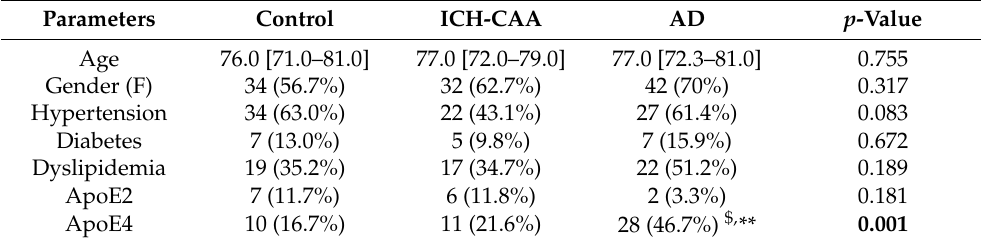
Table 1. Demographic and clinical